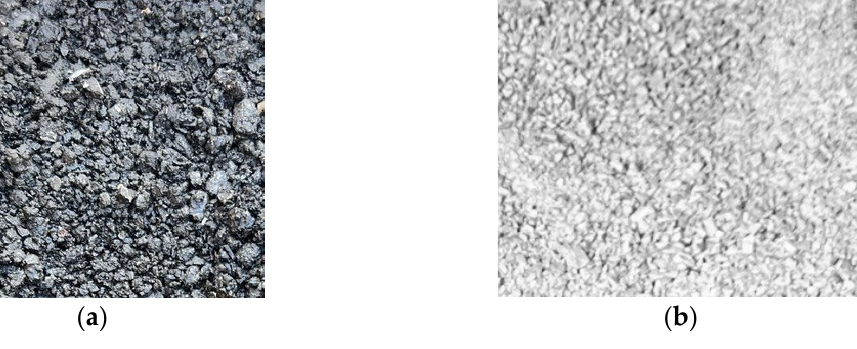
Table 1. Characteristics of the used cement.